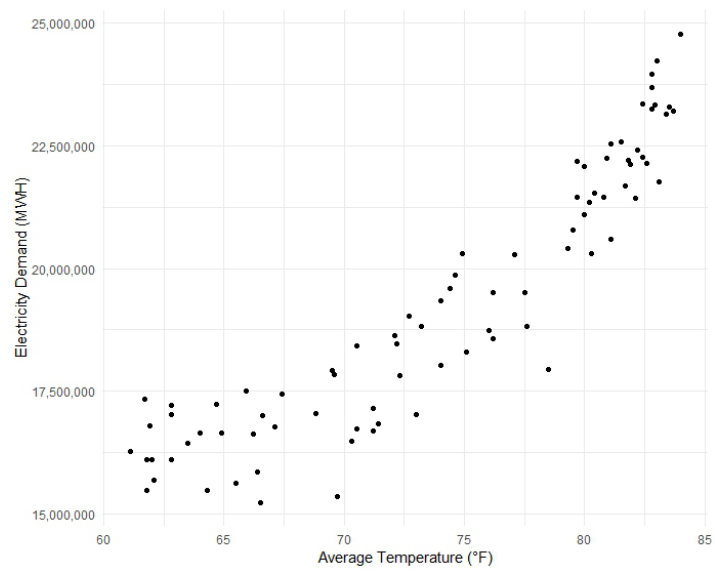
Figure 4. Electricity demand vs. average